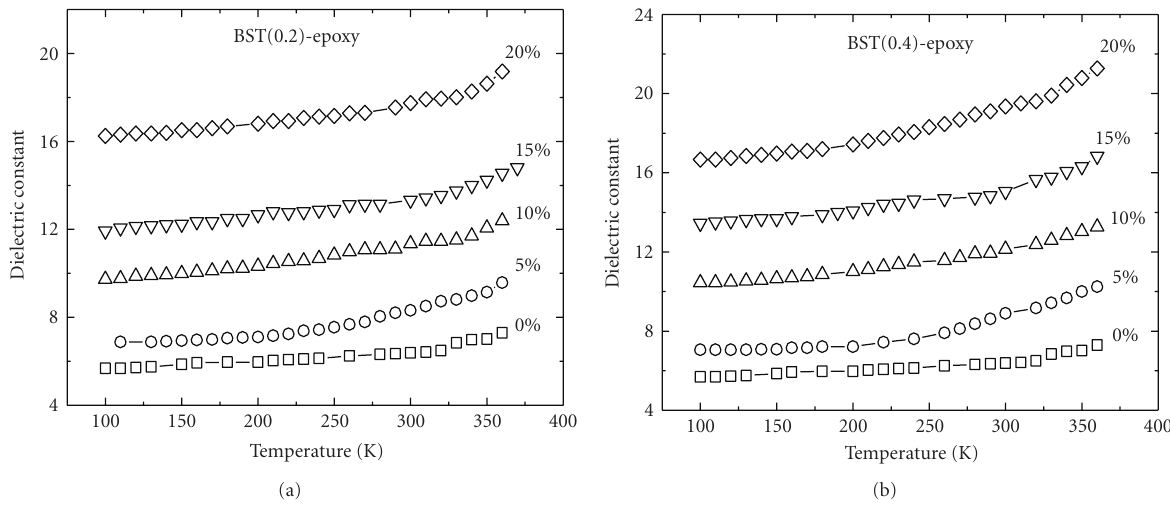
Figure 4: Dielectric constant for BST-epoxy composites as function of temperature for di ff erent volume fraction at 10KHz.